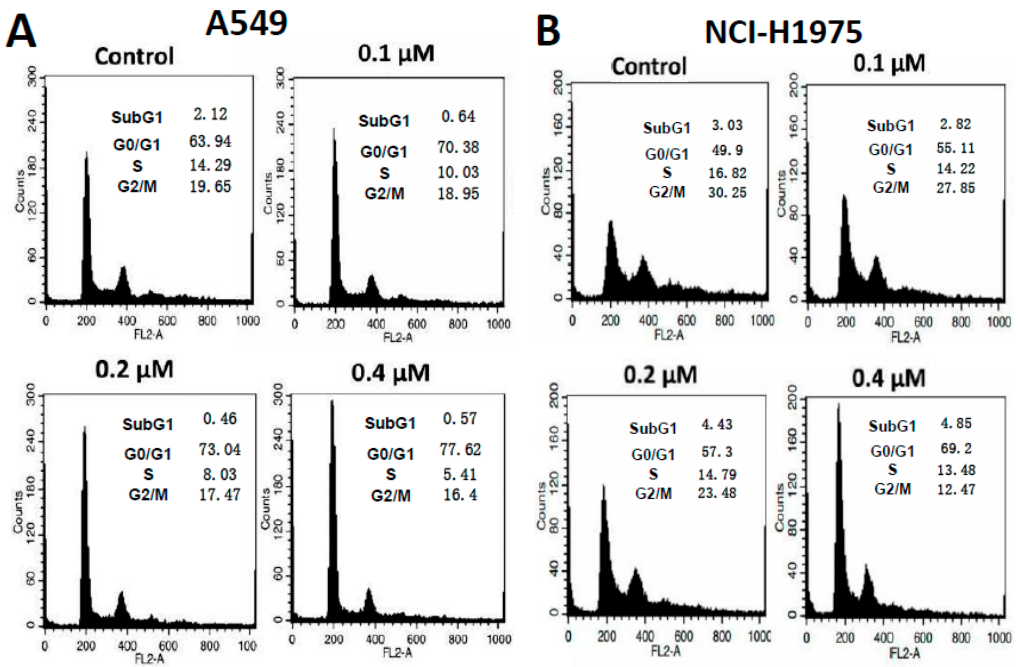
Figure 4. Cont Figure 4. Cont.